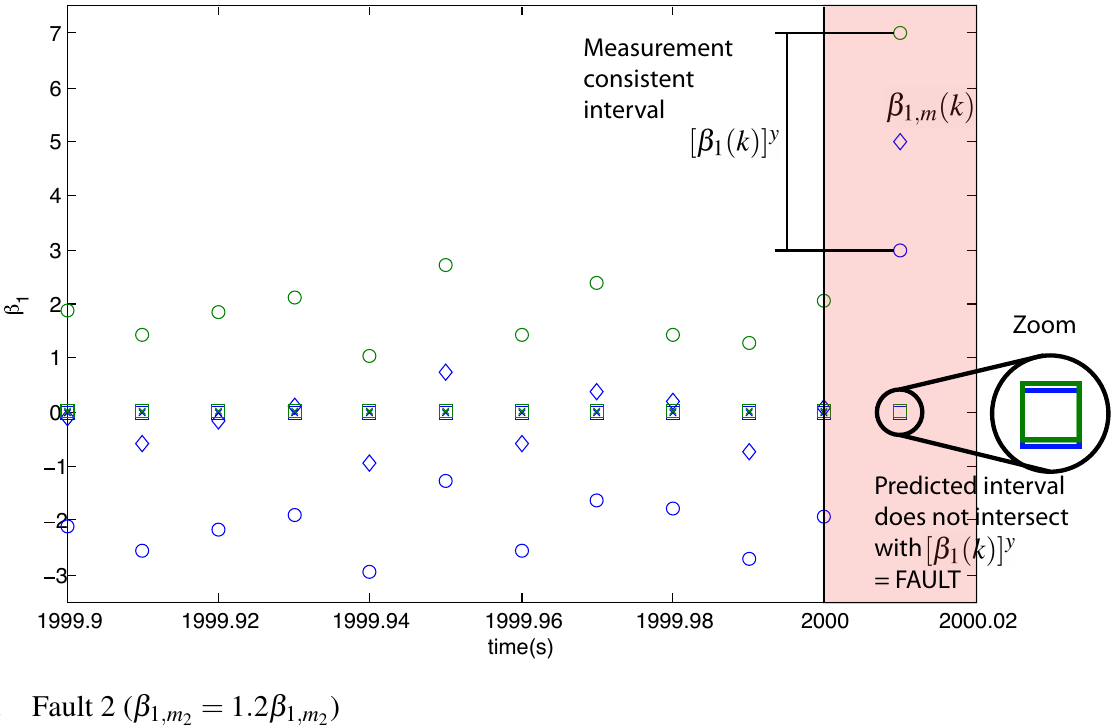
Figure 5. Detection of fault 1, (cid:5) : current measurement β